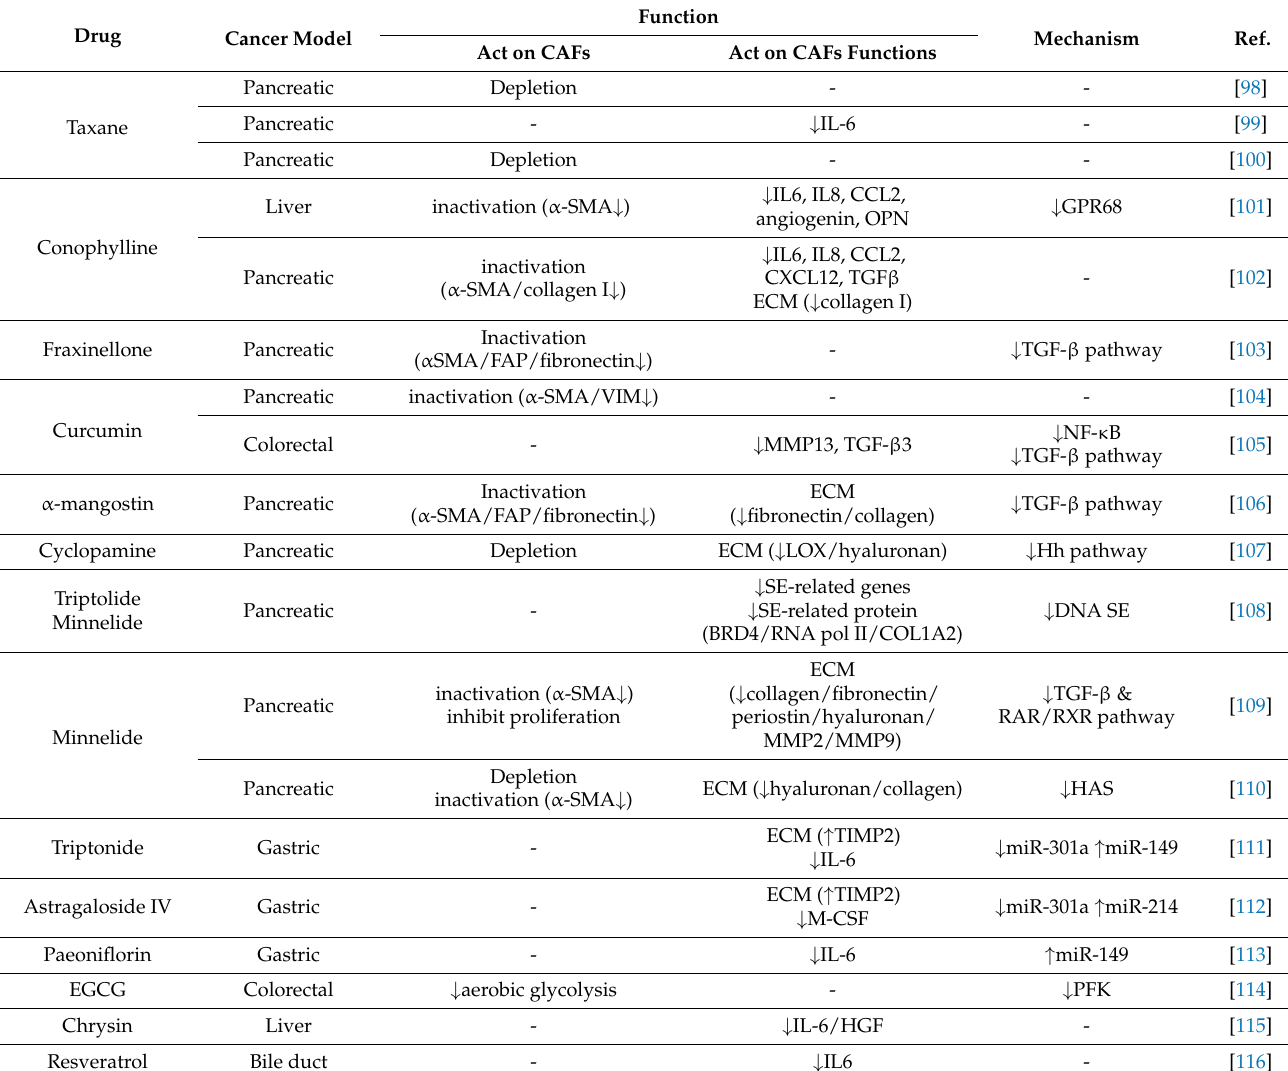
Table 1. Natural products targeting